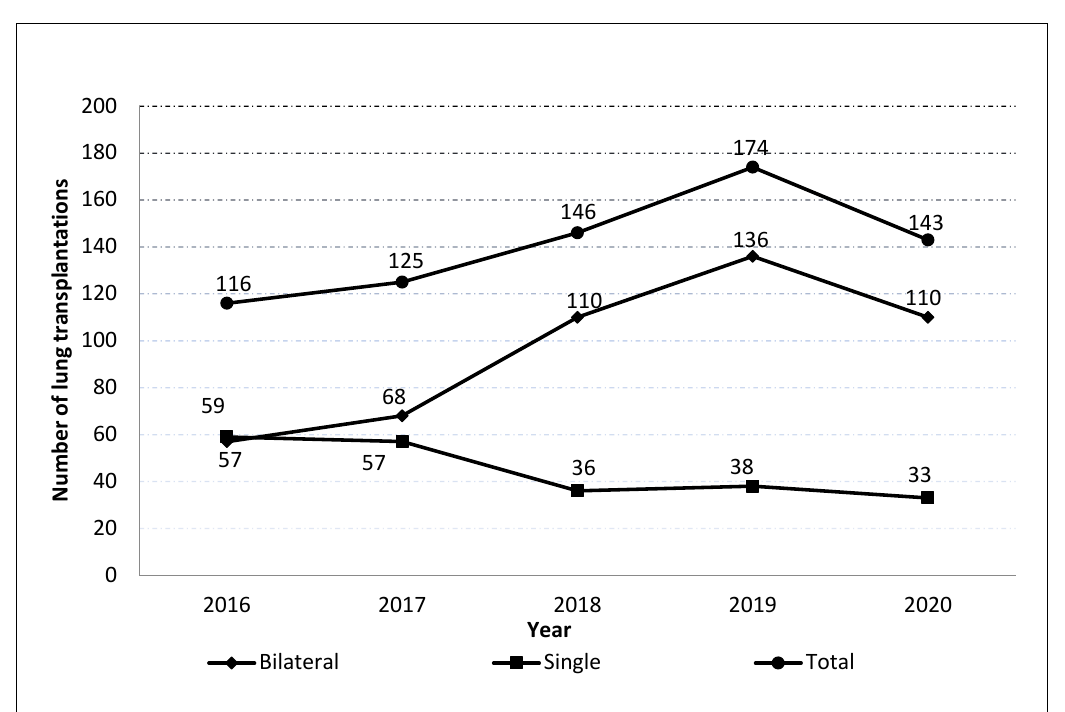
Figure 1. Number of lung transplantations in patient with COPD in Spain from 2016 to 2020, according to transplant type. Table 1. Clinical characteristics of patients with COPD who underwent a lung transplantation in Spain from 2016 to